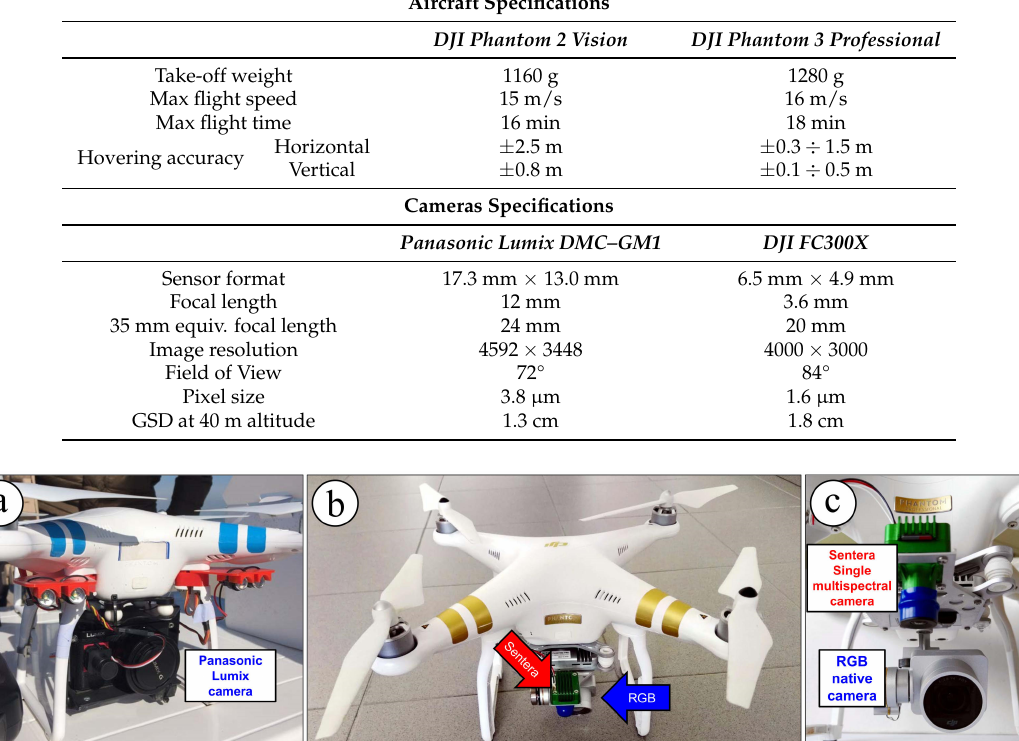
Figure 5. ( a ) The DJI Phantom 2 Vision equipped with the Panasonic Lumix camera; ( b ) The DJI Phantom 3 Professional equipped with both the RGB native camera (highlighted in blue) and a Sentera Single multispectral sensor (highlighted in red); ( c ) A detail on both the DJI Phantom 3 cameras, showing the nadiral fixed arrangement of the Sentera Single